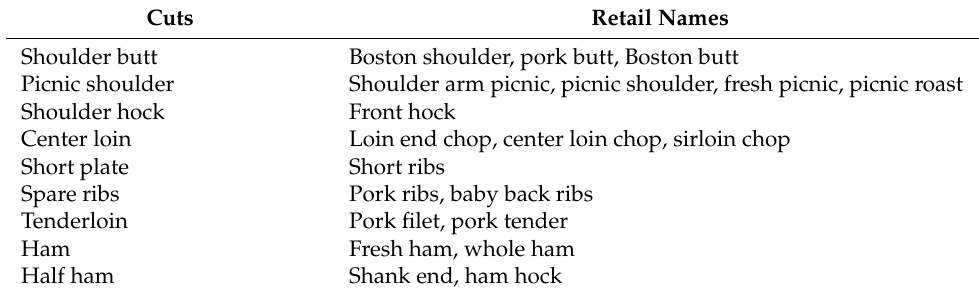
Figure 1. Diagram of American pork cuts (https://animalscience.unl.edu/pork-meat-identification, accessed on 1 February 2021). Table 2. Retail names of pork cuts.